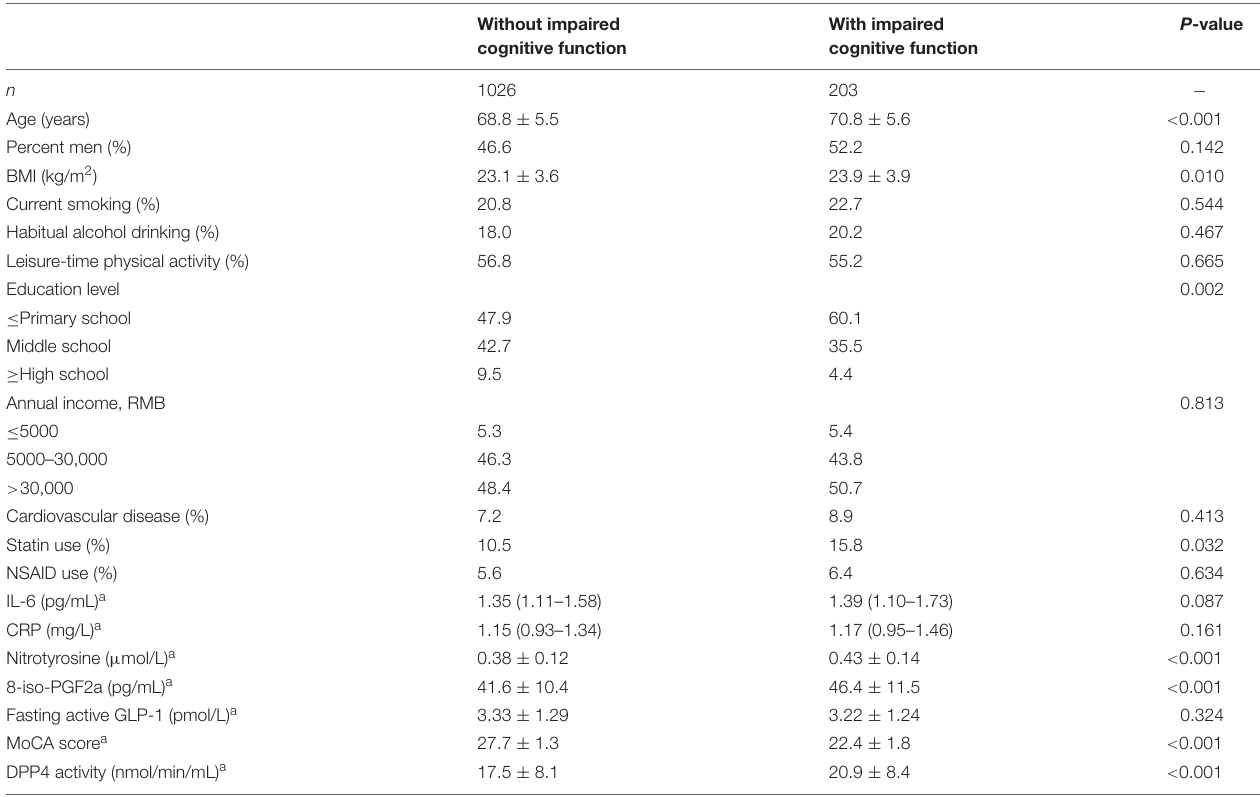
TABLE 2 | Characteristics of the 1229 participants by impaired cognitive function.